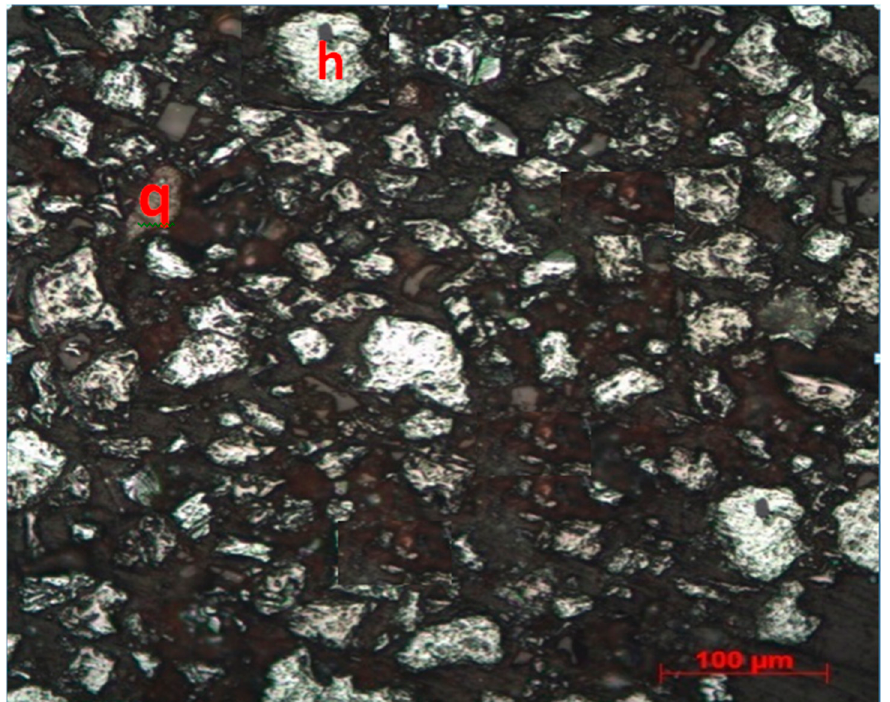
Figure 8. Fine inclusions of quartz with hematite grains. h: hematite, q: quartz. Based on the response analysis of flotation of the WHIMS concentrate, a maximum grade of 65.10% Fe of the flotation concentrate could be achieved by optimizing the process variables at a feed size of D 80 of 82 µ m, a depressant dosage of 0.5 kg/t, and a collector dosage of 0.25 kg/t with a recovery of 89.7% with respect to its WHIMS concentrate at 1 T intensity and a D 80 of 82 µ m, as shown in Figure 9a. Similarly, a maximum recovery of 95.42% Fe on the flotation concentrate could be achieved by optimizing the process variables for the WHIMS concentrate at 1 T intensity, a D 80 of 200 µ m, a depressant dosage of 0.5 kg/t, and a collector dosage of 0.25 kg/t with a grade of 52.5% Fe, as shown in Figure 9b. It is also observed from the optimization study that, to achieve a better grade, the process parameters should be at a middle value of D 80 . Optimal result by were obtained by WHIMS followed by flotation at 1 T intensity, an MOG of − 106 µ m, a D 80 of 82 µ m, a pH of 10, and 20% solids with a 0.5 kg/t caustic starch depressant and a 0.25 kg/t dodecyl amine collector, producing a concentrate with 64.60% Fe, 3.12% SiO 2 , 1.00% Al 2 O 3 , 4.12% SiO 2 + Al 2 O 3 , a